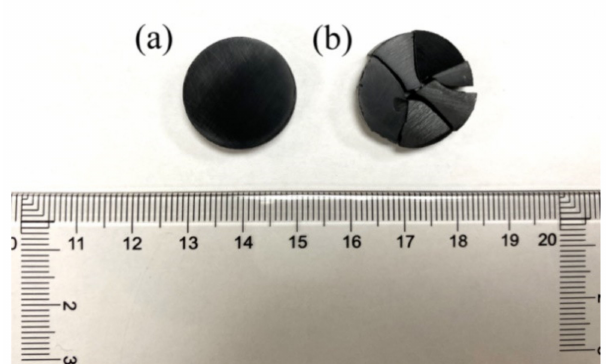
Figure 2. An image of LiFePO 4 samples processed using SPS with ( a ) AC and ( b ) DC (Ø 20 mm). The DC SPS samples consistently cracked because of the volume phase change during SPS.